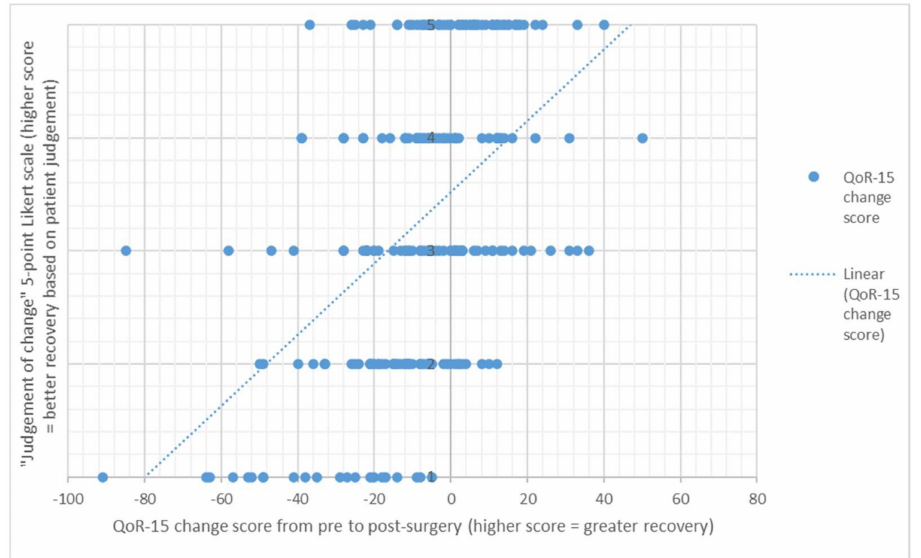
Figure 1. From pre to one week post-surgery, scatter plot of the QoR-15 change score and the “judgement of change” score on the 5-point Likert scale, n = 247 (1 = Worse; 2 = A little worse; 3 = Much the same; 4 = A little better; 5 = Better).